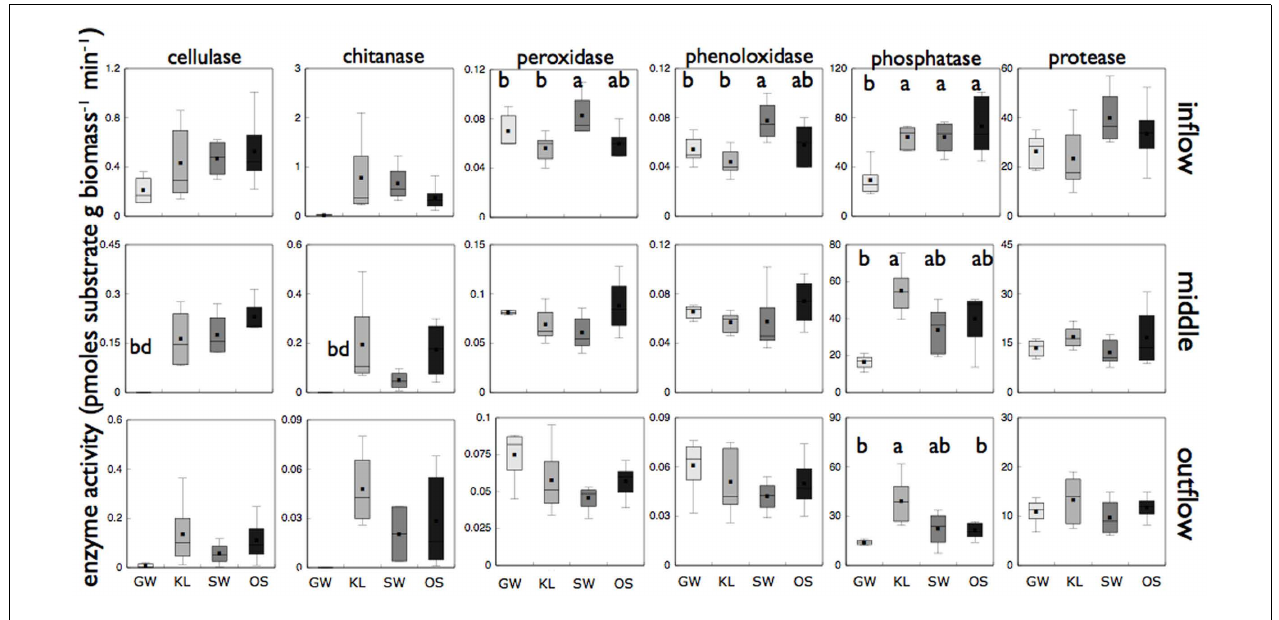
FIGURE 6 | Reports biomass specific enzyme activity for each of six different enzyme assays for microbial biofilms sampled from the inflow, middle, and outflow section of each reactor. “bd” Indicates enzyme activity was below detection for that treatment.